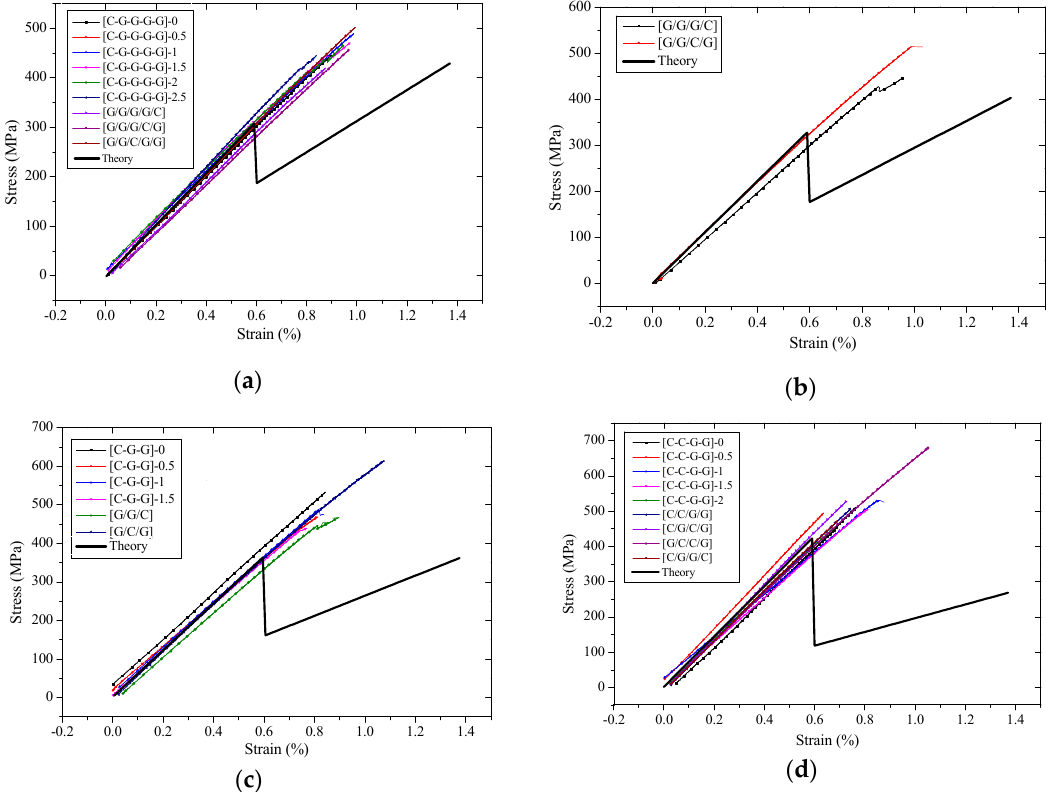
Figure 10. Experimental and theoretical compression stress-strain curves of interlayer and intralayer hybrid composites at various hybrid ratios: ( a ) C:G=1:4; ( b ) C:G=1:3; ( c ) C:G=1:2; ( d ) C:G=1:1.